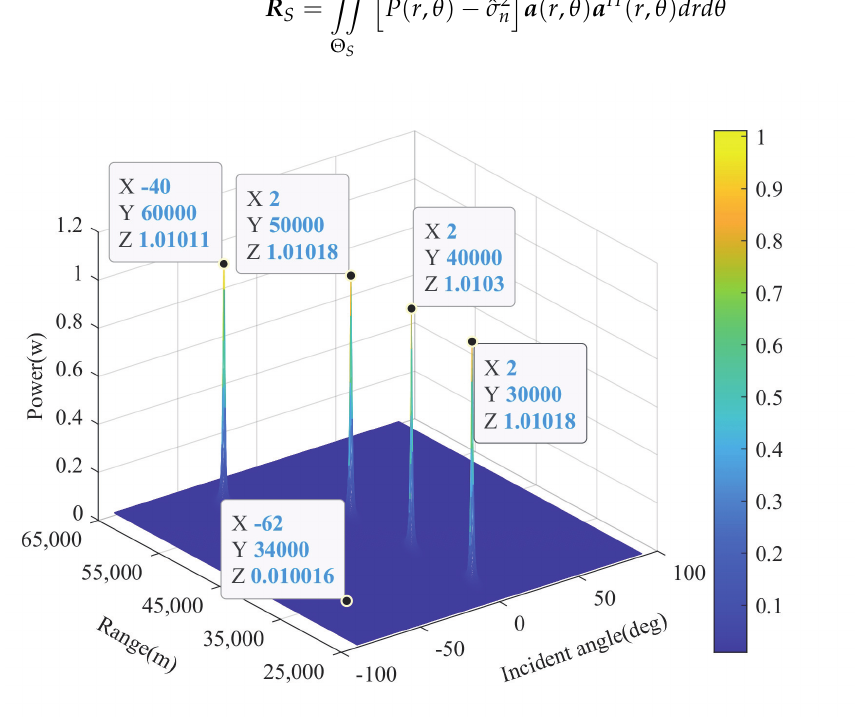
Figure 4. Power spectrum distribution of desired signal and